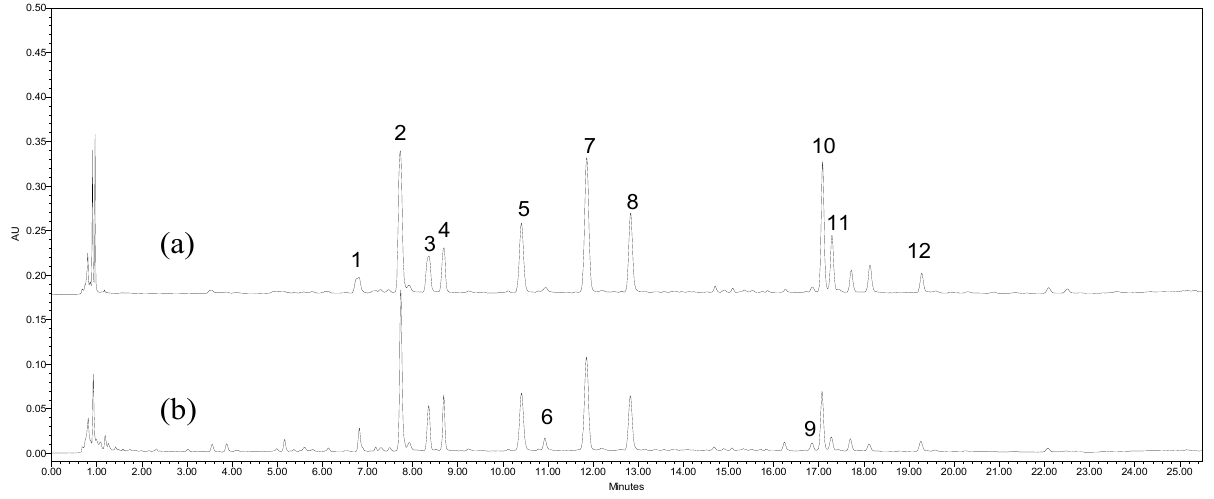
Figure 1. Typical chromatograms of SL ethanolic extract ( a ) and aqueous extract ( b ) at 280